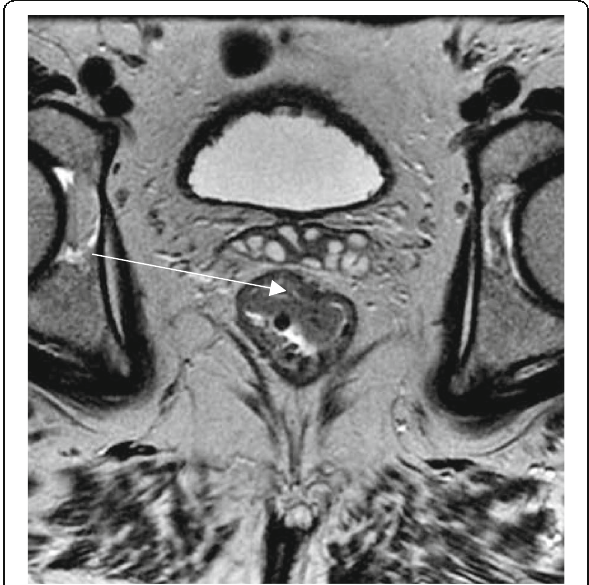
Fig. 7 The high-signal intensity of the submucosa. High-resolution axial T2WI shows a semiannular low-lying lesion extending from 10 to 1 o ’ clock confined to the rectal wall with no signs of invasion of the muscularis propria and preserved high-signal intensity of the submucosal layer (arrow). The lesion was staged as